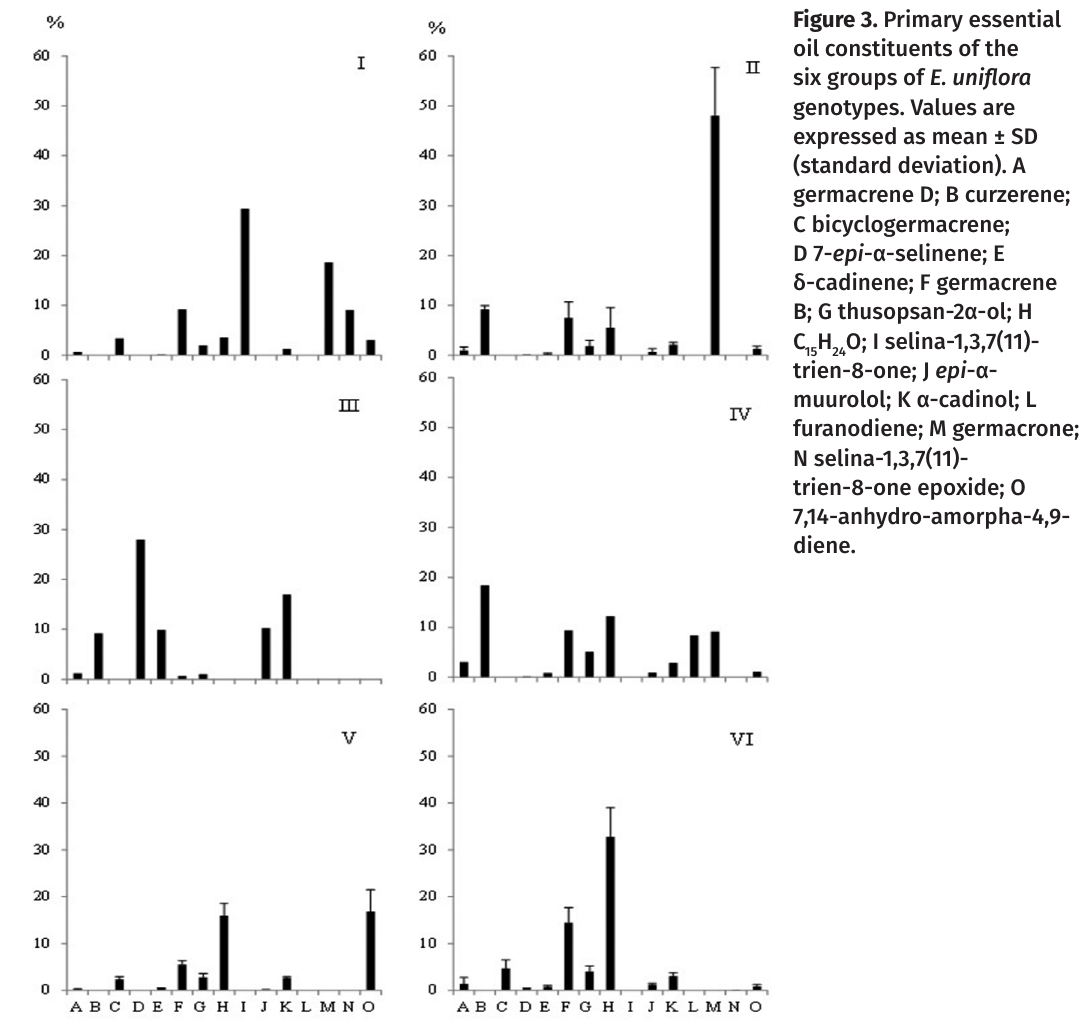
Figure 3. Primary essential oil constituents of the six groups of E. uniflora genotypes. Values are expressed as mean ± SD (standard deviation). A